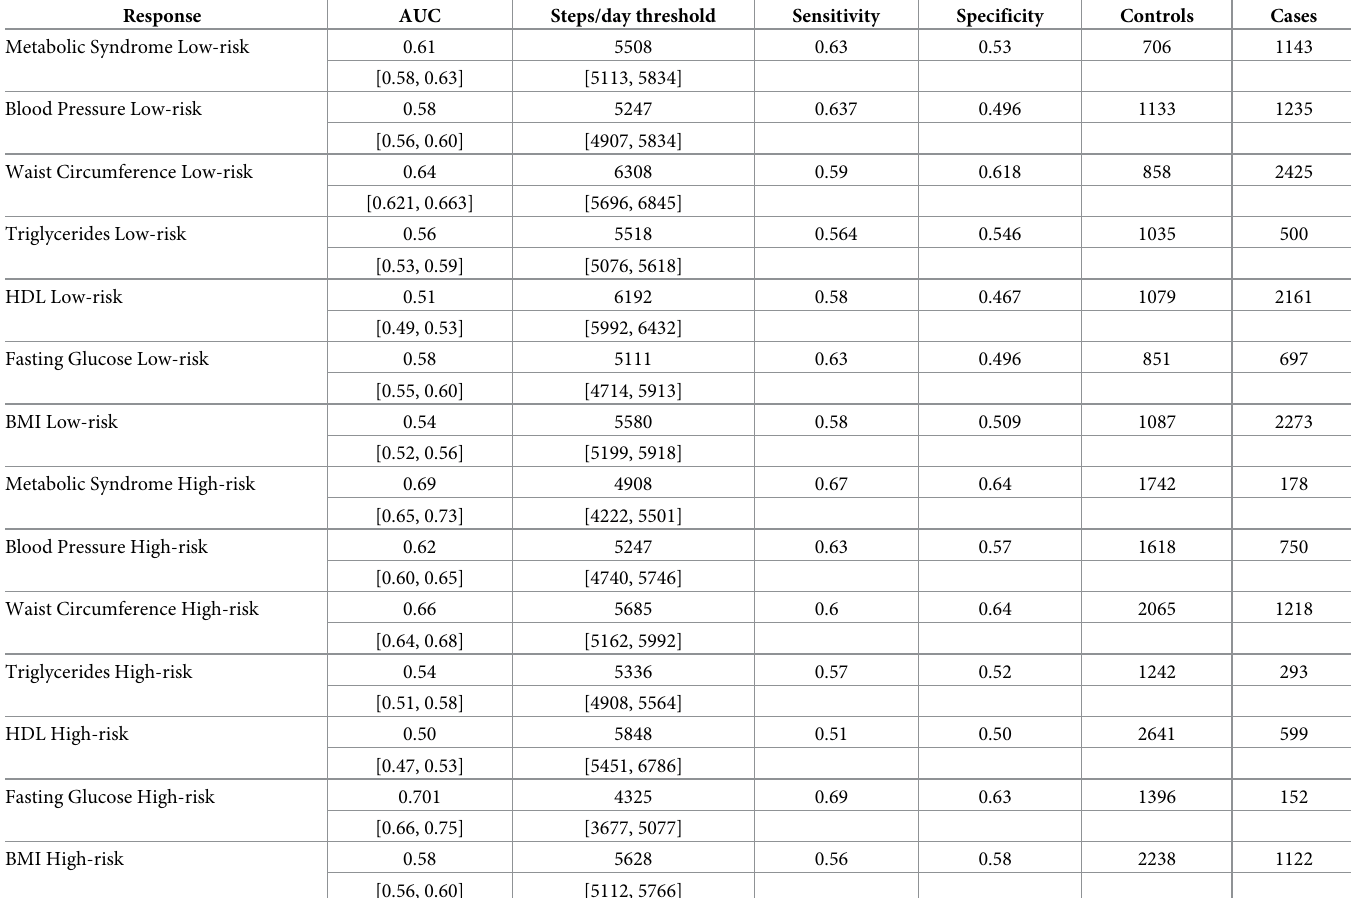
Table 4. Steps/day, AUC, sensitivity, specificity and thresholds that delineate cardiometabolic risk factors. Steps/day below the threshold classifies the at-risk popula- tion. The sample size and number of at-risk cases for each ROC analysis are provided.